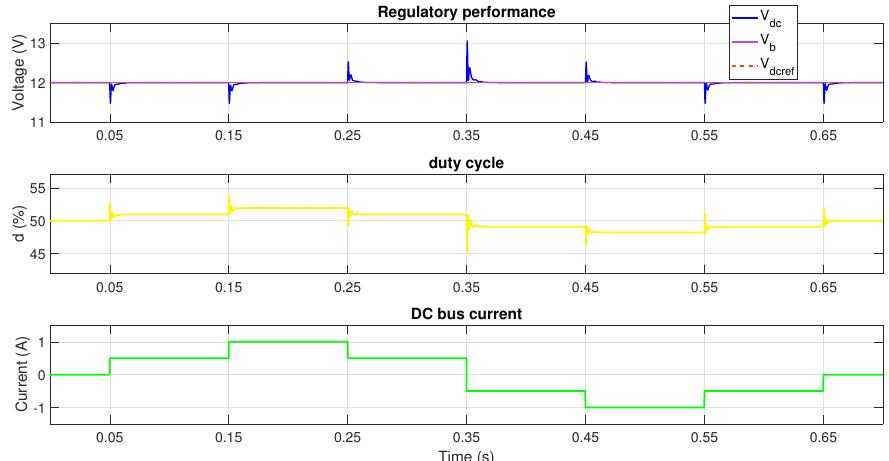
= 12 V (unitary gain mode). ref